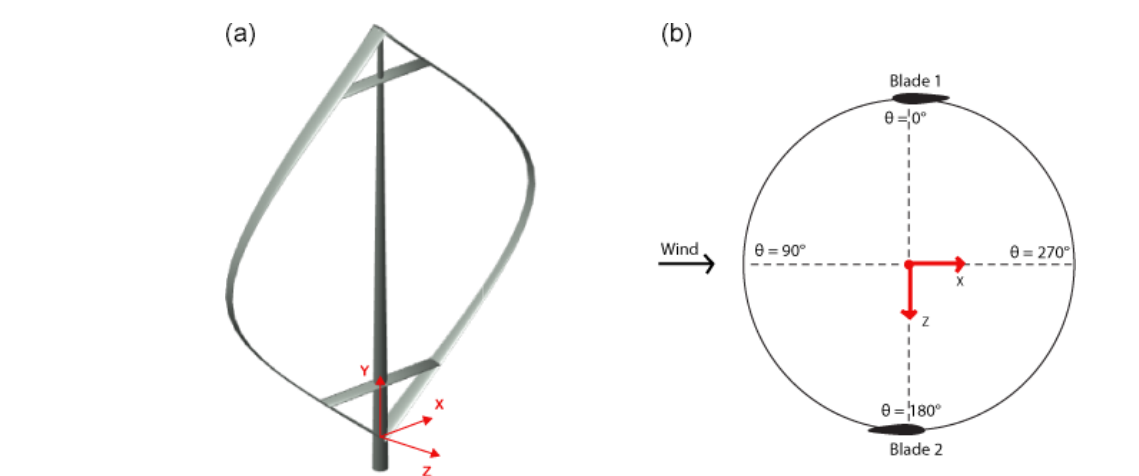
Figure 1. Schematic view of a two-bladed VAWT (a) and CACTUS coordinate system (b) .